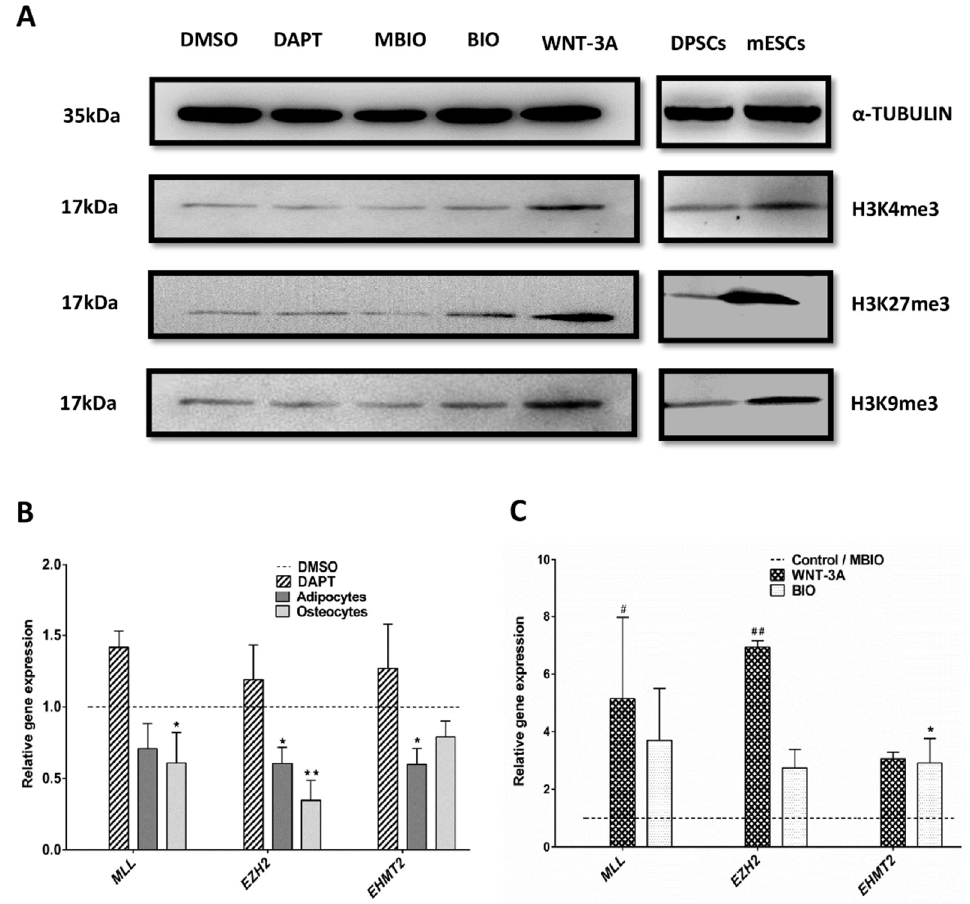
Figure 6. Wnt activation regulates H3 trimethylation tags in DPSCs. ( A ): Representative WBs showing protein levels of trimethylated H3K4me3, H3K27me3, and H3K9me3. α -TUBULIN was used as a protein loading control. Mouse ESCs were used as a positive control for high H3 methylation (right panel). Control on right panel shows untreated DPSCs grown in standard conditions. ( B , C ): Q-PCR analyses showing transcript expression levels for histone-methyltransferases placing H3K4me3 (MLL), H3K27me3 (EZH2) and H3K9me3 (EHMT2) epigenetic tags. Data are normalized to reference β -ACTIN and GAPDH levels and represented as the mean + SEM ( n = 3). *: p < 0.05; **: p < 0.01; ***: p < 0.001. Dunn’s Test, Kruskal- Wallis H Test. Asterisks (*) report significance with respect to controls PBS / DMSO, and Hash symbol (#) represents significance with respect to control MBIO. #: p < 0.05; ##: p <